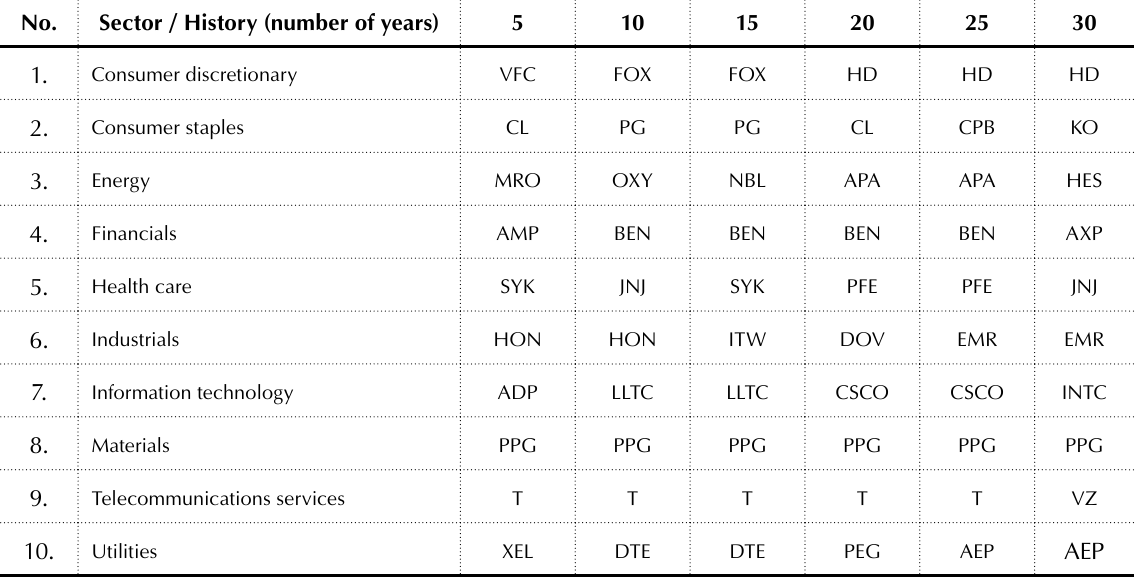
Table 2. The representatives of each sector according to time period